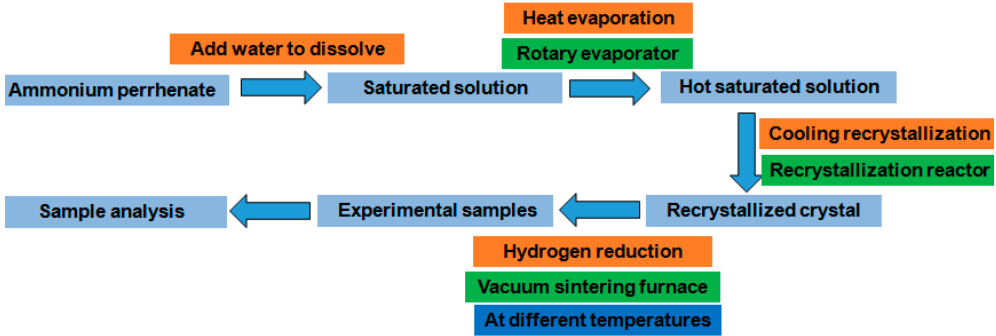
Figure 2. The experimental working procedure diagram.